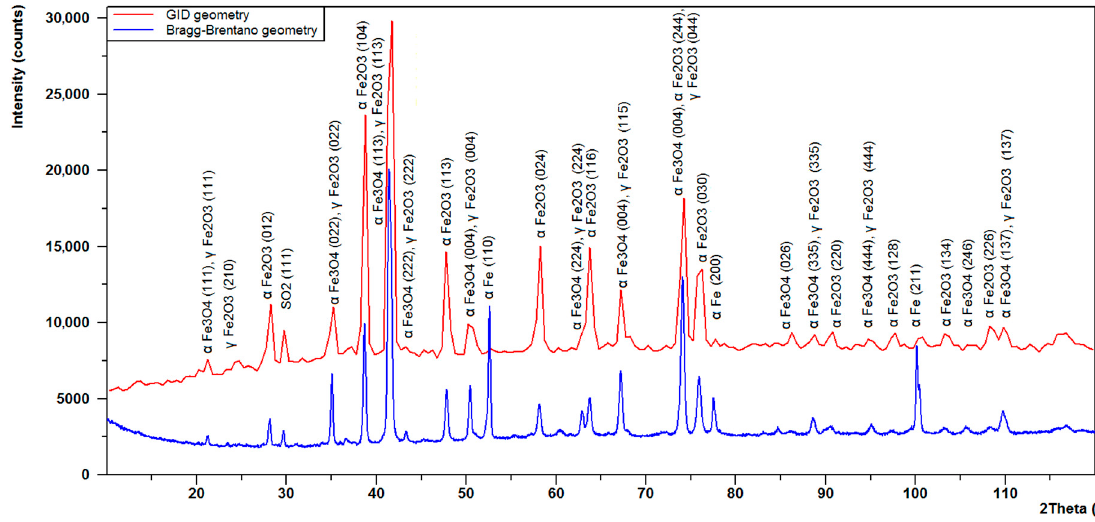
Figure 7. Diffractogram from a sample. Blue chart, Bragg–Brentano geometry; red chart, grazing incidence diffraction (GID) geometry. SiMo 3. 1.09% Mo.